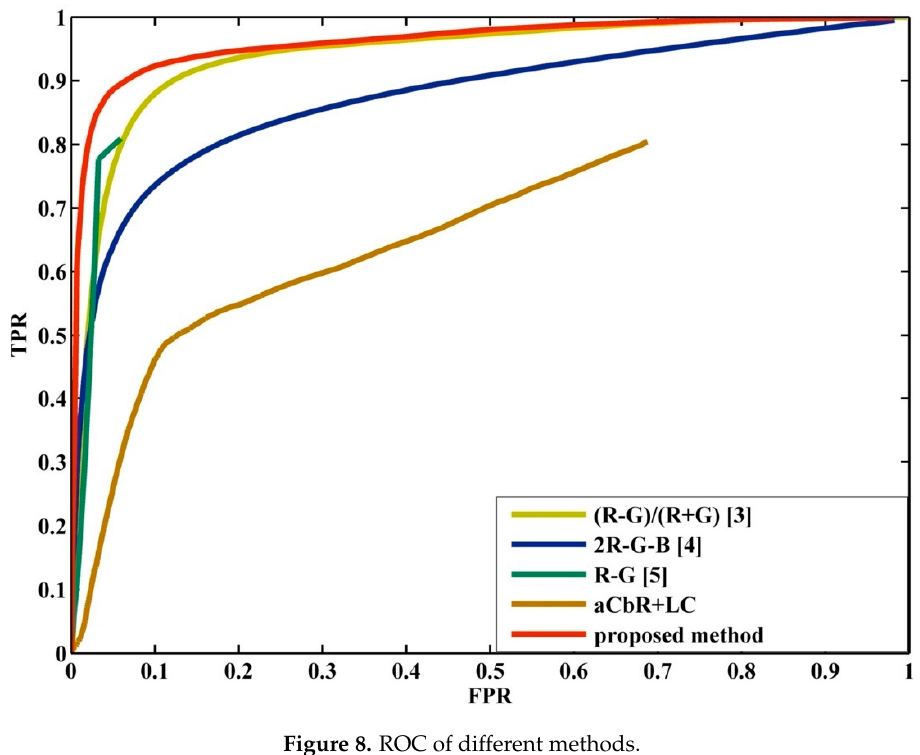
Figure 8. ROC of different methods.